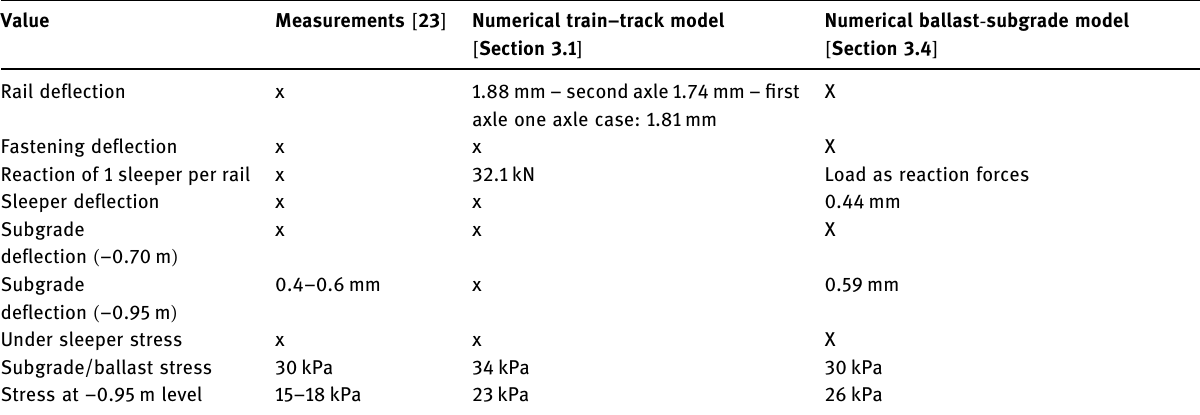
Table 6: Results of the comparative calculations and validation